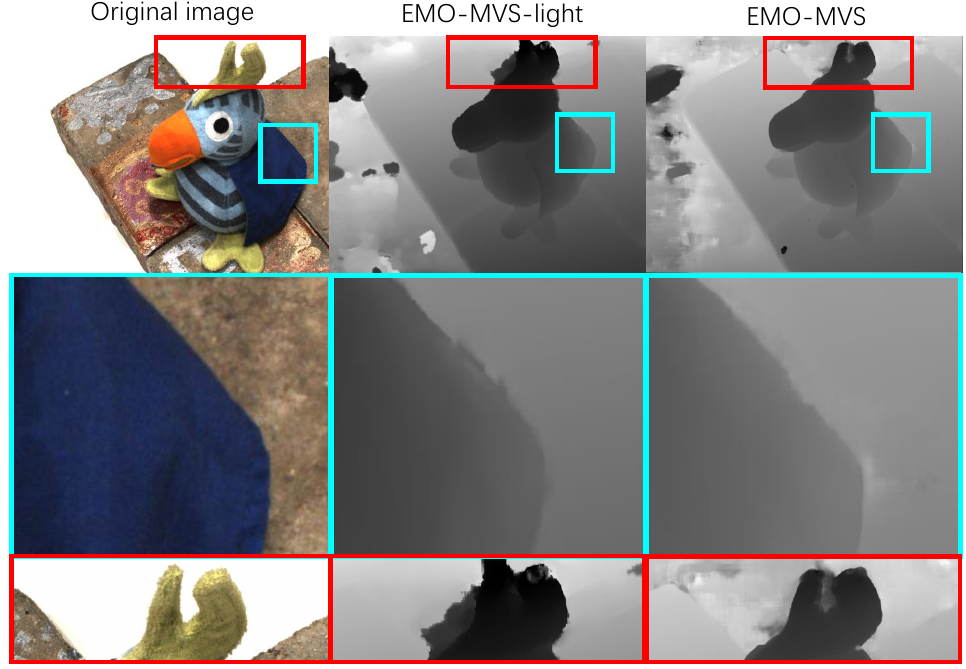
Figure 9. Comparison with and without Error-Aware